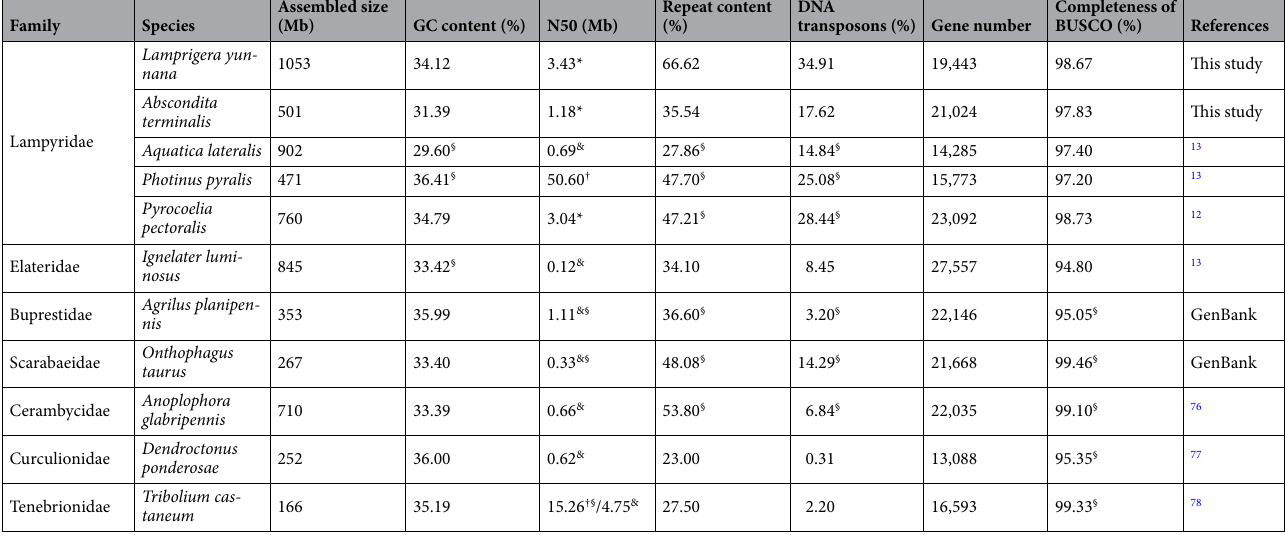
Table 1. Comparison of reference genomes among beetles. *Contig †Chromosome and unplaced scaffolds & Scaffold § Predicted in this study using the same pipeline as in L. yunnana and A. terminalis . BUSCO: the Benchmarking Universal Single-Copy